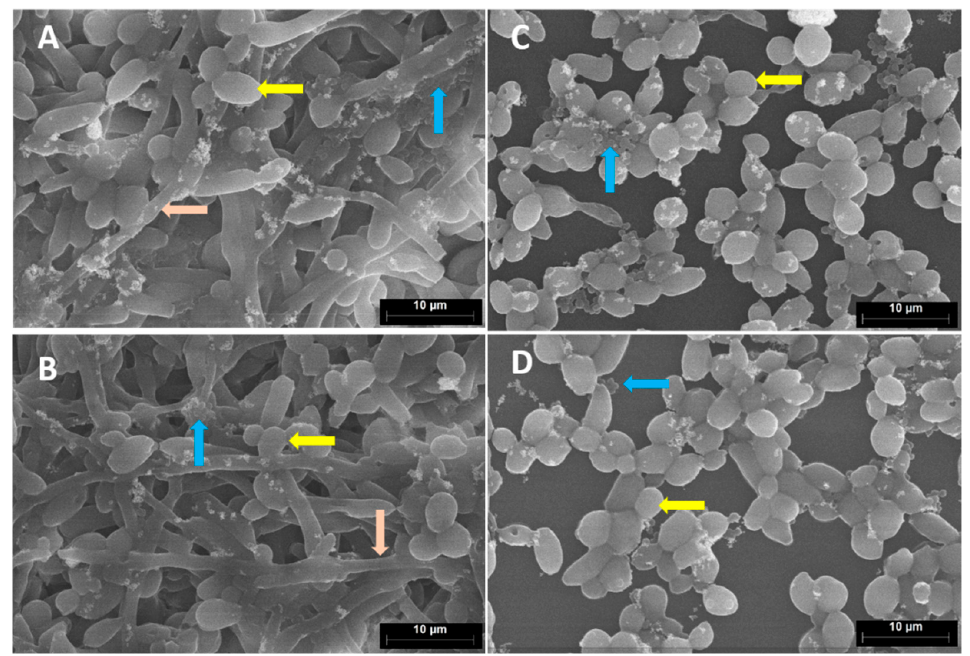
Figure 4. SEM micrographs of mixed biofilms of C. albicans -MRSA2 after 48 h of incubation; ( A ) control without treatment, ( B ) treated with OXA (2 mg/mL), ( C ) treated with FAR (300 μ M), ( D ) treated with FAR (300 μ M)/OXA (2 mg/mL). The scale bars are 10 μ m. Yellow arrows show yeast cells, pink arrows show hyphae and blue arrows show staphylococcal cells.